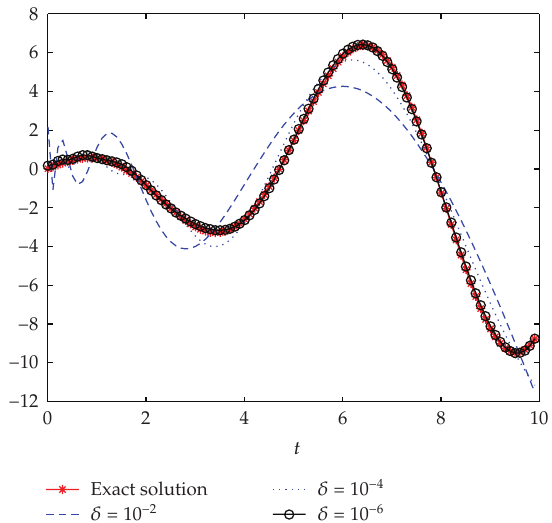
Figure 12: Example 3.12: the stability of the approximate solution.